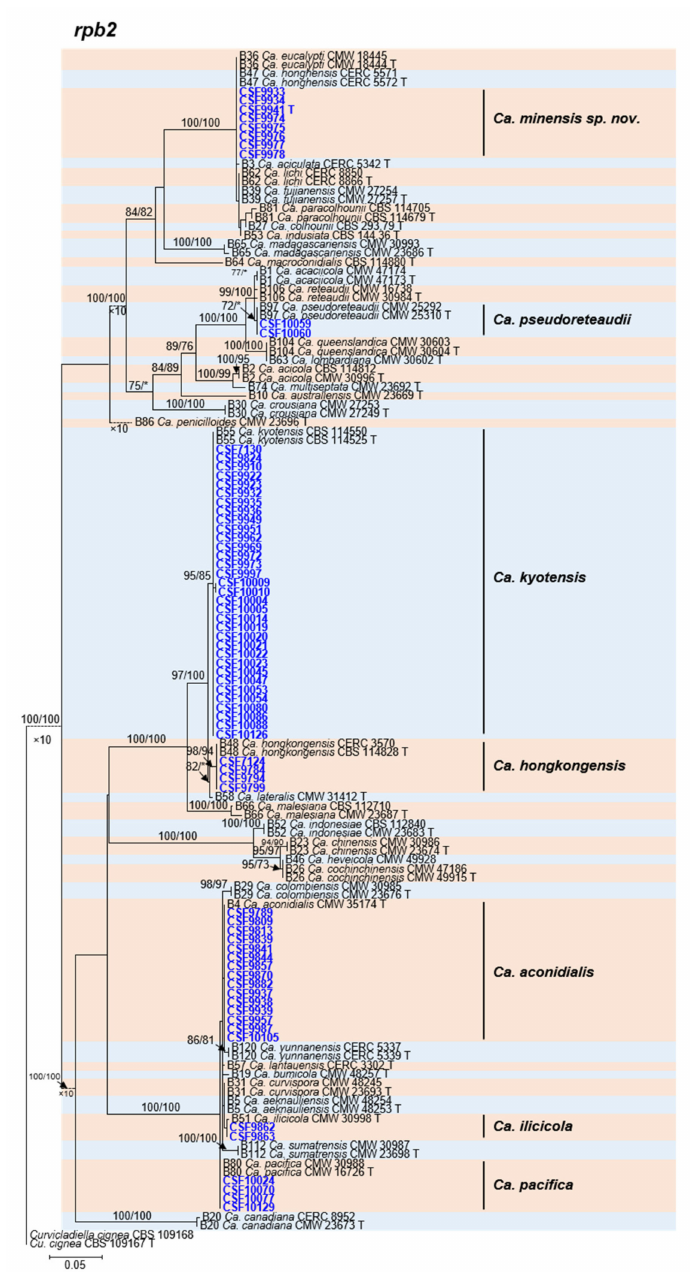
Figure A4. Phylogenetic tree of Calonectria species based on maximum likelihood (ML) analyses of rpb2 gene sequences. Bootstrap value ≥ 70% for ML and MP analyses are presented at the branches. Bootstrap values lower than 70% are marked with “*”, and absent analyses values are marked with “-”. Ex-type isolates are marked with “T”. Isolates sequenced in this study are highlighted in blue and bold type. The “B” species codes are consistent with the recently published results in Liu and co-authors [18]. The tree was rooted to Curvicladiella cignea (CBS 109167 and CBS